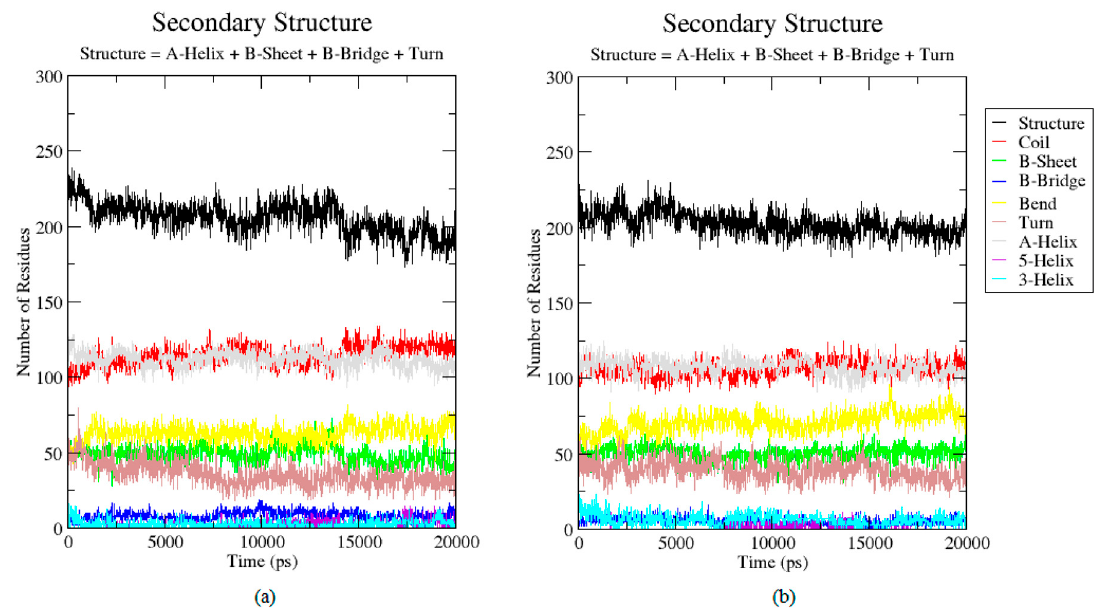
Figure 5. The secondary structure analysis for the earth-grown and space-grown structures: ( a ) Earth-grown structure; ( b ) Space-grown